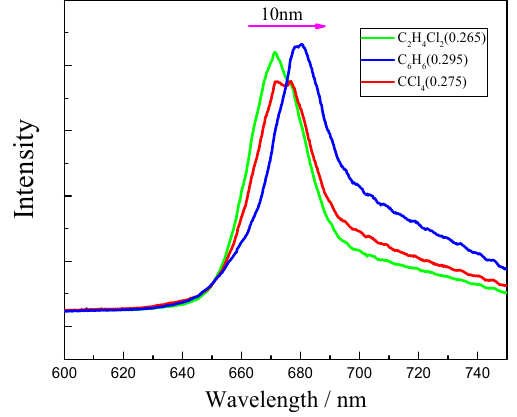
Figure 4. Fluorescence spectra red-shift by increasing solvent polarizability.